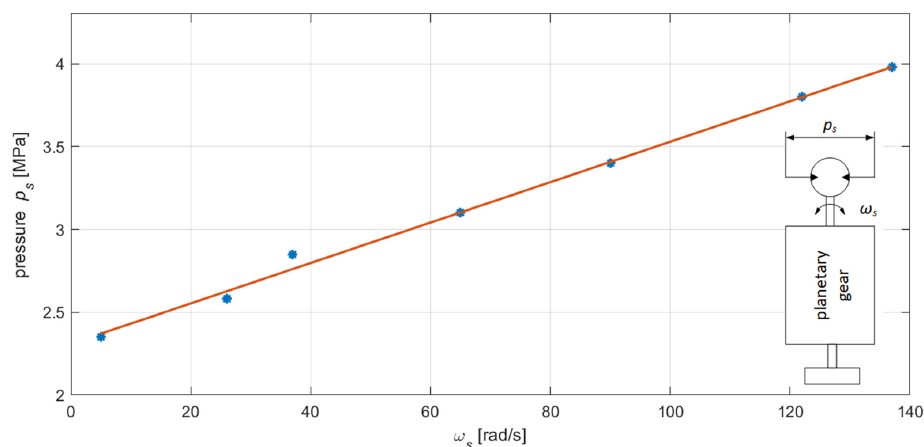
Figure 4. Resistance to motion of the gear motor M2C1613 and of the coupled planetary gear OH-500 as a function of angular velocity, 𝜔 (cid:3046) , of idle running.